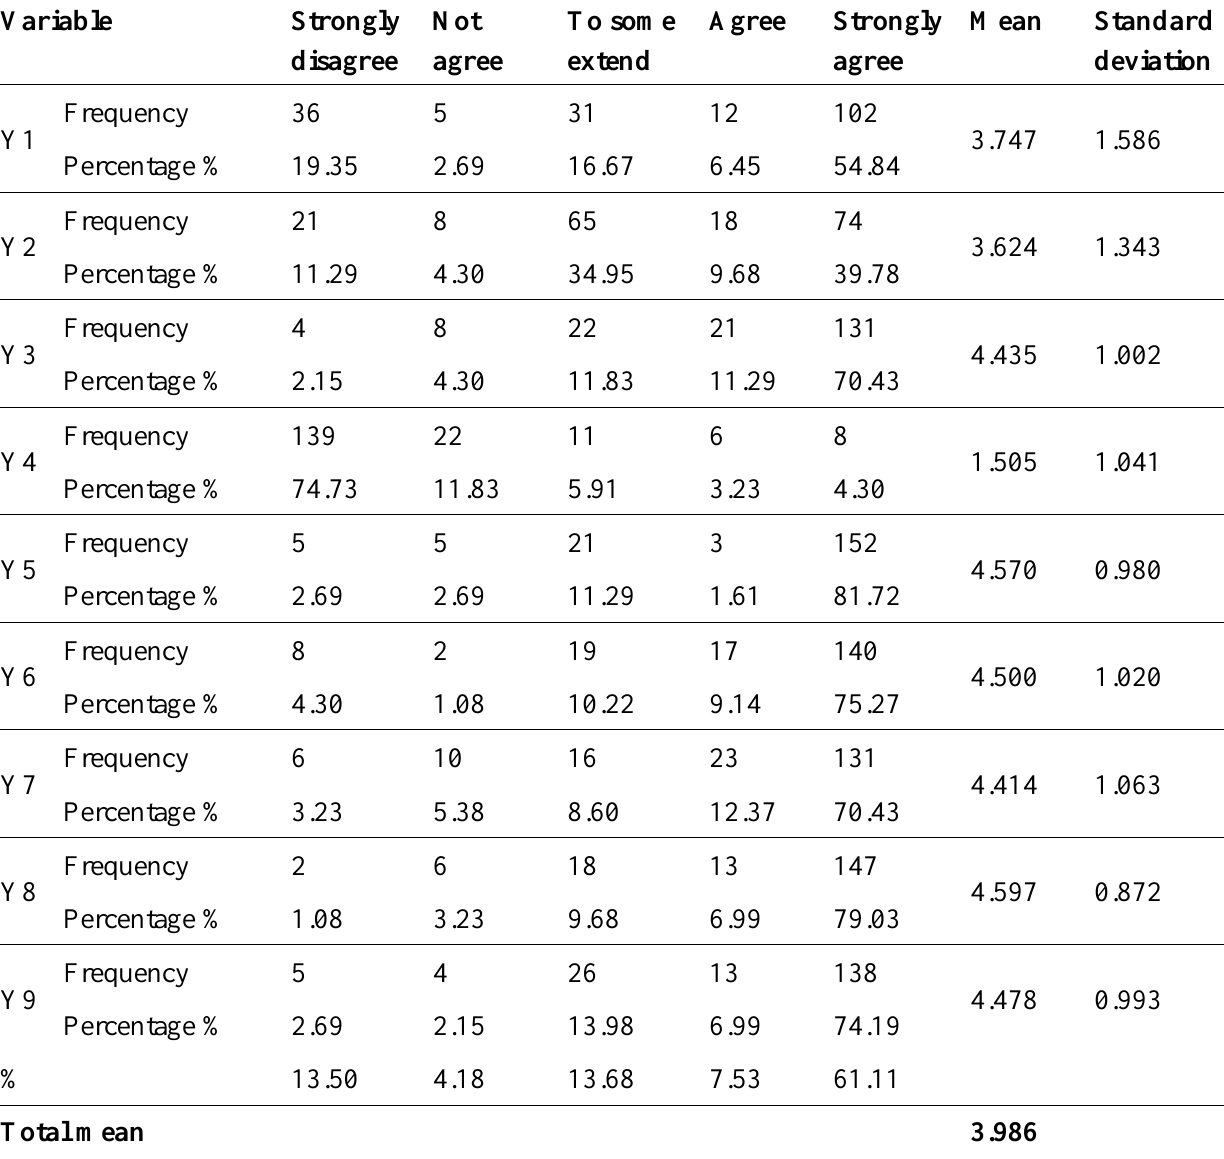
Table 5. Descriptive statistics for the axis (geo-economic)